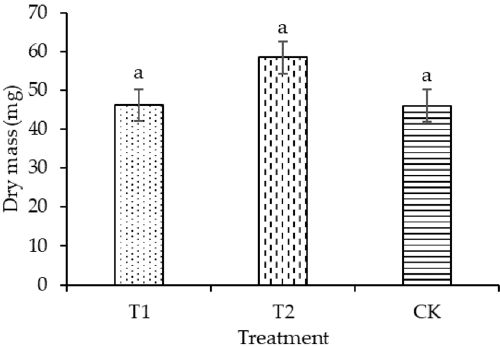
Figure 6. Dry mass in shoot of seedling under different treatments.